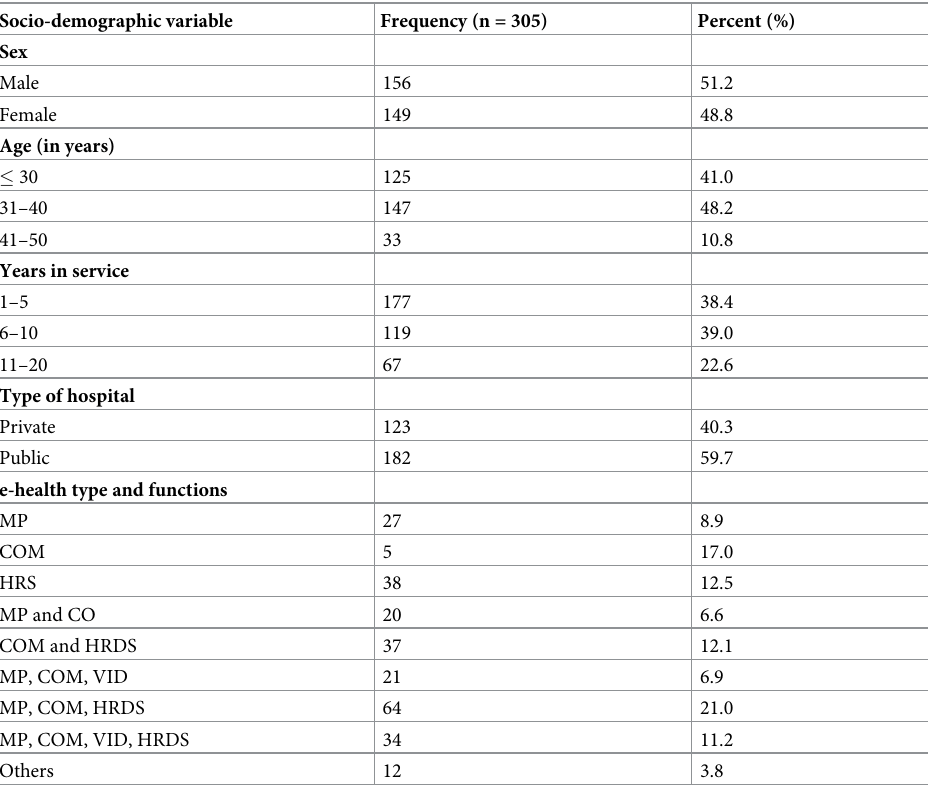
Table 2. Respondents’ characteristics, e-health type and type of hospital.